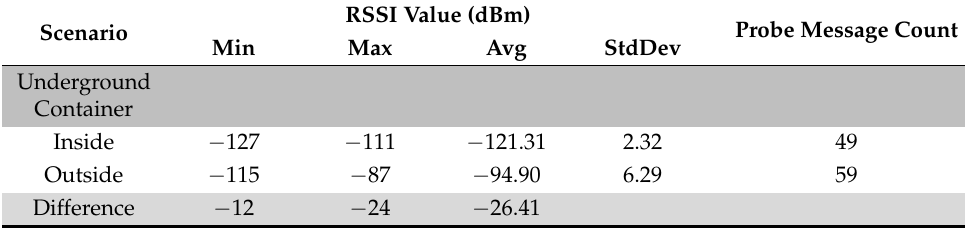
Table 3. RSSI measurements on underground Figure 18. Underground container received messages: ( a ) radio quality RSSI; ( b ) SNR measurements.